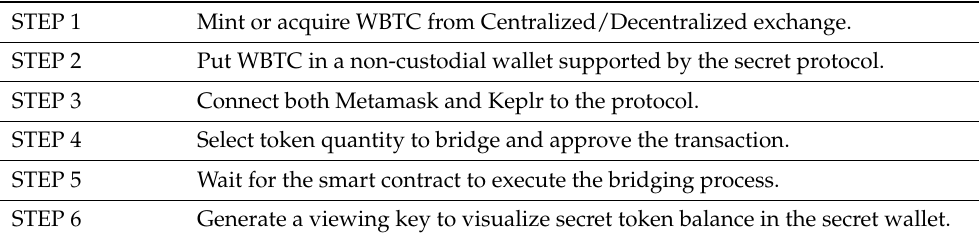
Table 6. Minting sWBTC (Snip-20) on the Secret